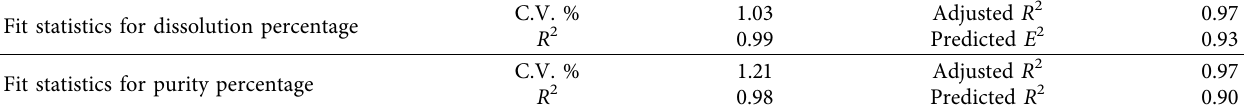
Table 5: Fit statistics.